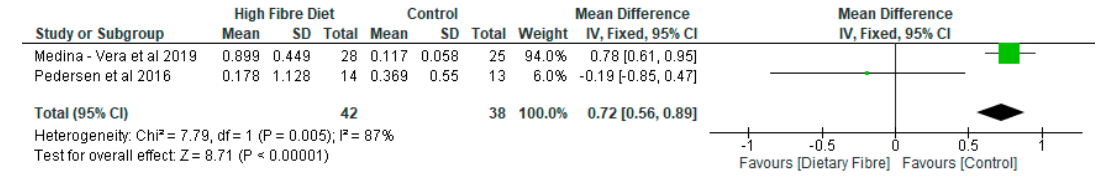
ff ect of dietary fibre on Bifidobacterium Figure 3. The effect of dietary fibre on Bifidobacterium (%). Figure 3. The e